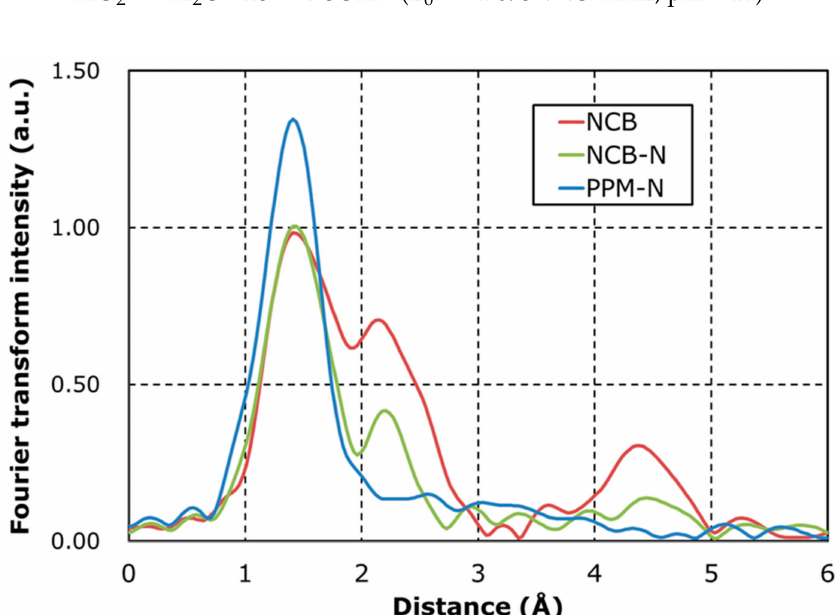
Figure 1. Radial structure function around Fe, calculated from the Fourier-transforms of the Fe K-edge extended X-ray absorption fine structure (EXAFS) spectra of NCB, NCB-N, and